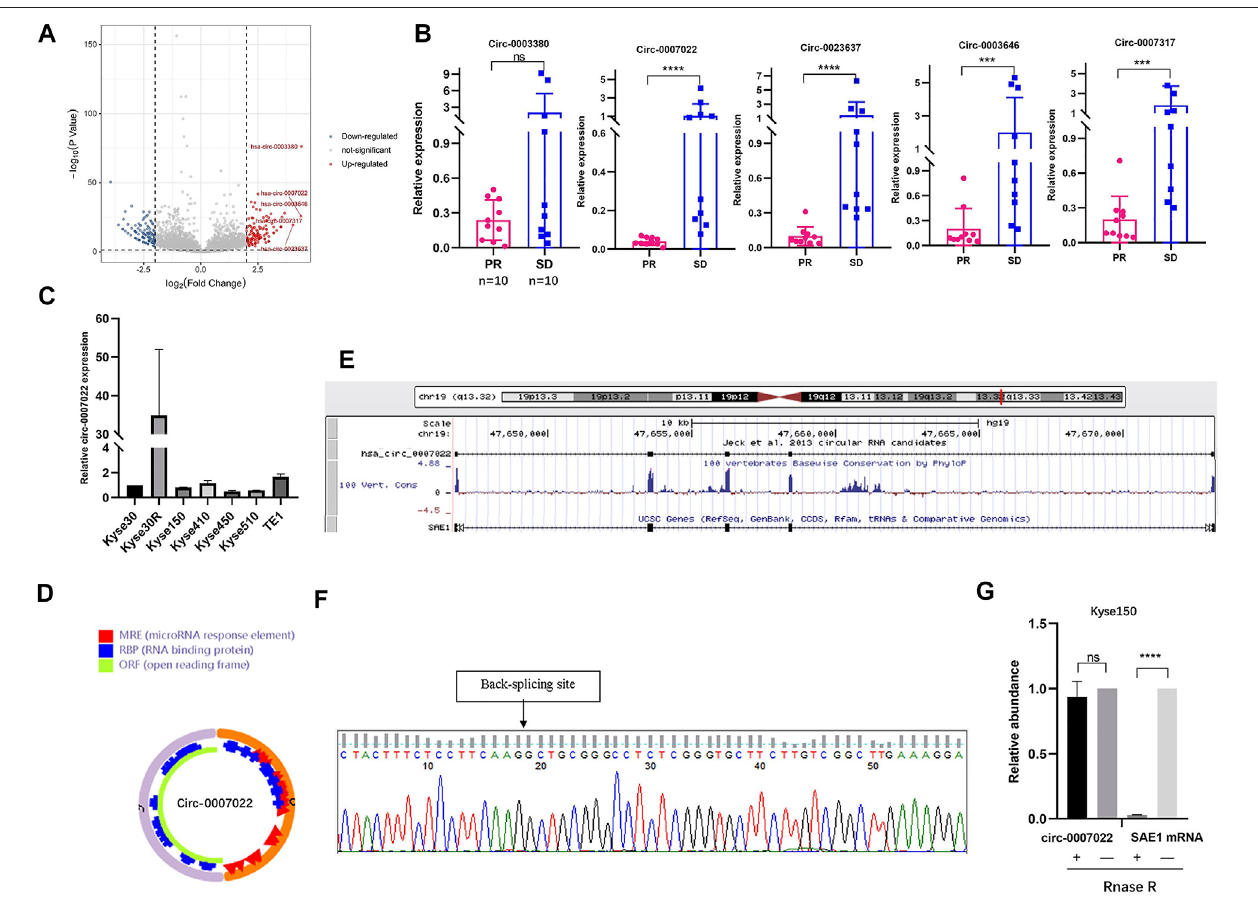
FIGURE 2 | Circ-0007022 expression was upregulated in radioresistant ESCC cell line. (A) Volcano plot shown difference in known circRNA expression pro fi les between Kyse30R and Kyse30 cell lines. (B) The qRT-PCR con fi rmed the different levels of circ-0003380, circ-0007022, circ-0023637, circ-0003646, and circ- 0007317 in tumor tissues of ESCC patients. (C) The qRT-PCR assay detected the expression of circ-0007022 in multiple ESCC cell lines. (D,E) Schematic illustration shown the ring structure of circ-0007022 was composed of two exons (the orange and pink semicircular lines) and the genomic loci circ-0007022. (F) Sanger sequencing revealed the “ head to tail ” splicing sites of circ-0007022 where the arrow pointed. (G) RNase R treatment revealed that circ-0007022RNA was resistant to RNase R in ESCC cells, but not mSAE1. Data are expressed as mean ± SD, ns > 0.05, *** p < 0.001, **** p < 0.0001.